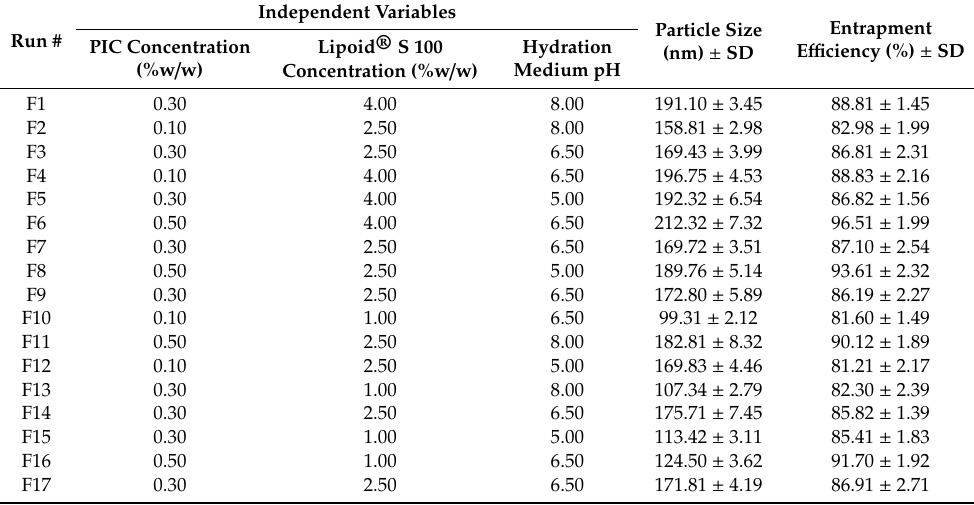
Table 2. Experimental runs, variables levels, and responses observed of PIC-E prepared based on a Box–Behnken